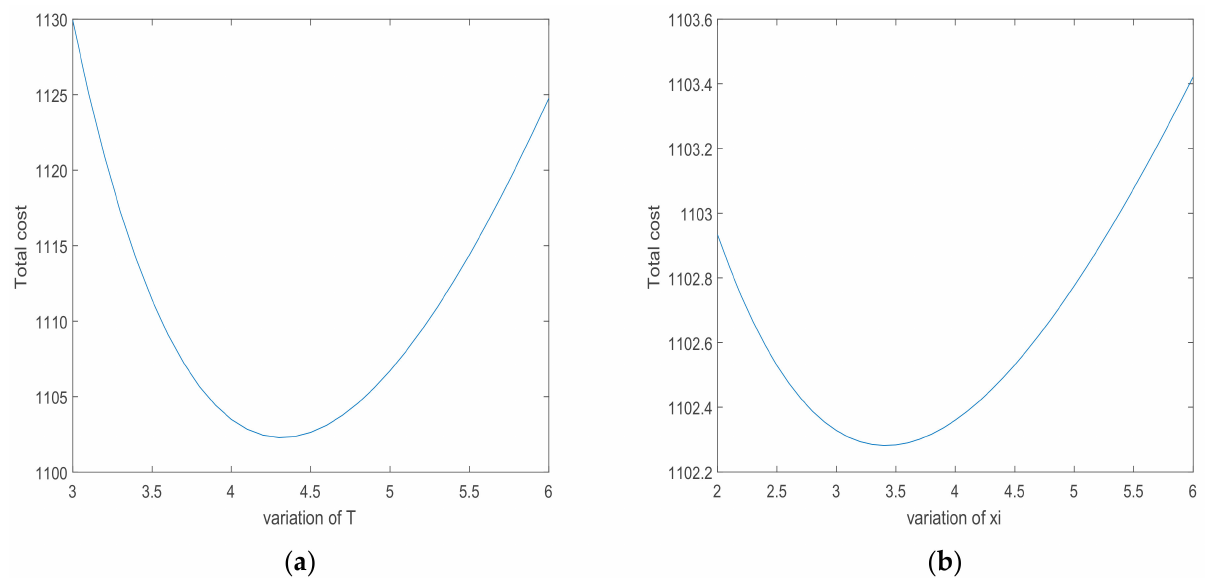
Figure 4. Total cost function (TC) regarding: ( a ) replenishment cycle (T); ( b ) preservation technology cost per unit time ( ξ